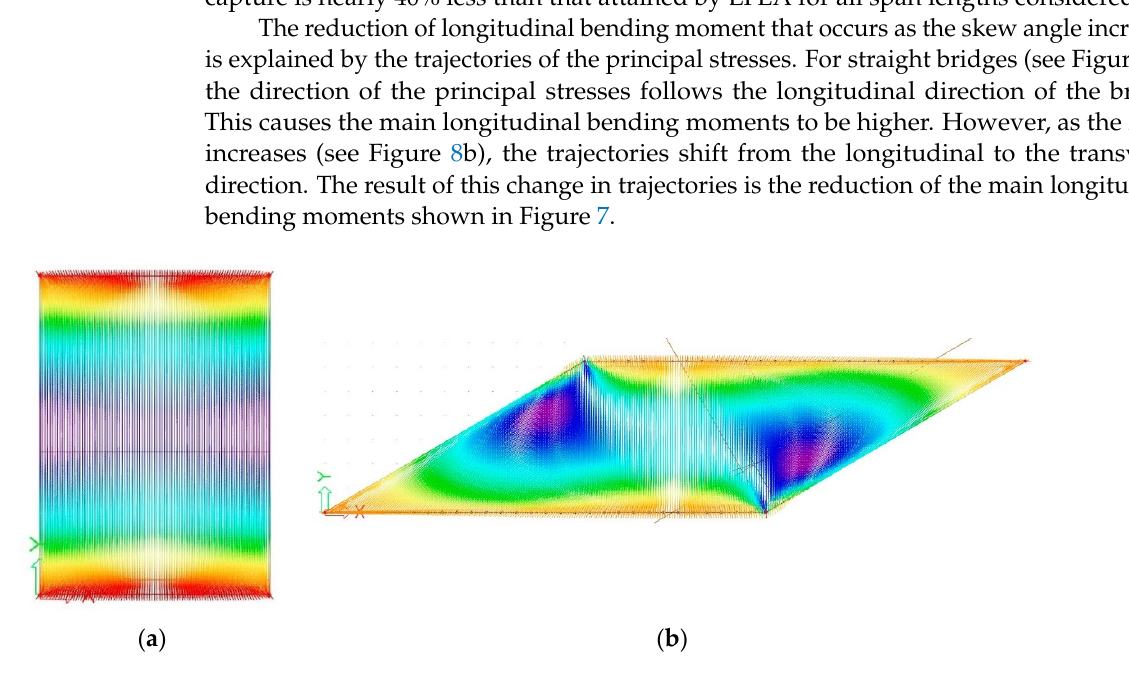
Figure 8. Trajectories of the principal stresses for the 12 m long, two-lane case study bridge. (a) Straight α = 0 ◦ , (b) skewed α = 60 ◦